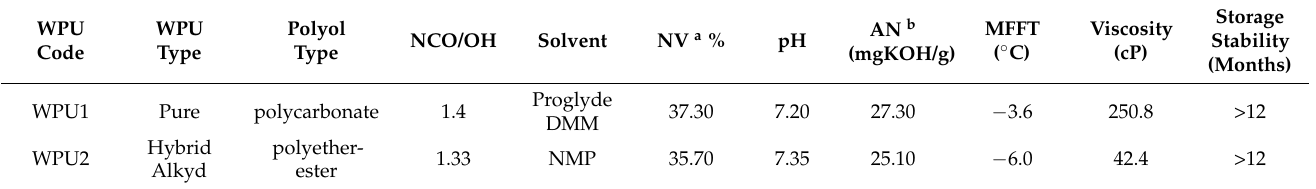
Table 2. Specifications/Physical Properties of the formulated/developed